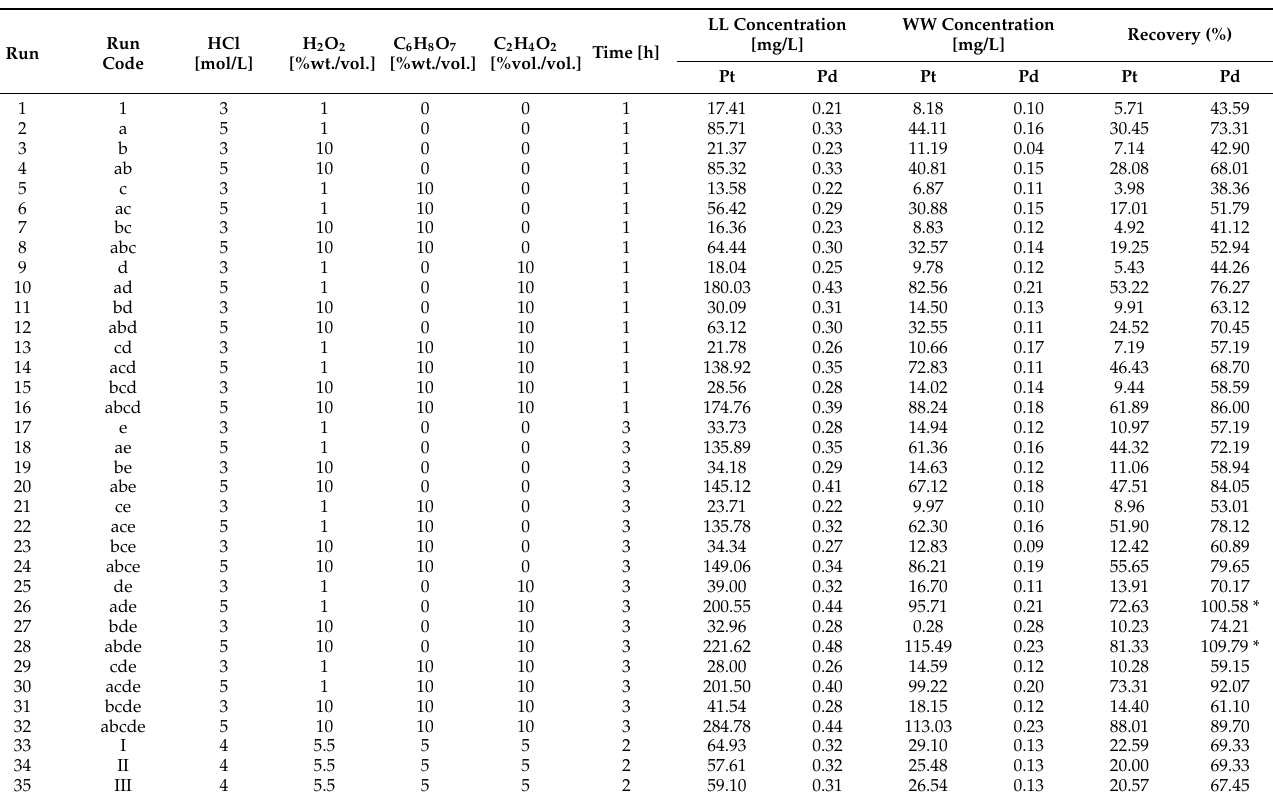
Table 4. Results of Pt and Pd leaching according to the factorial